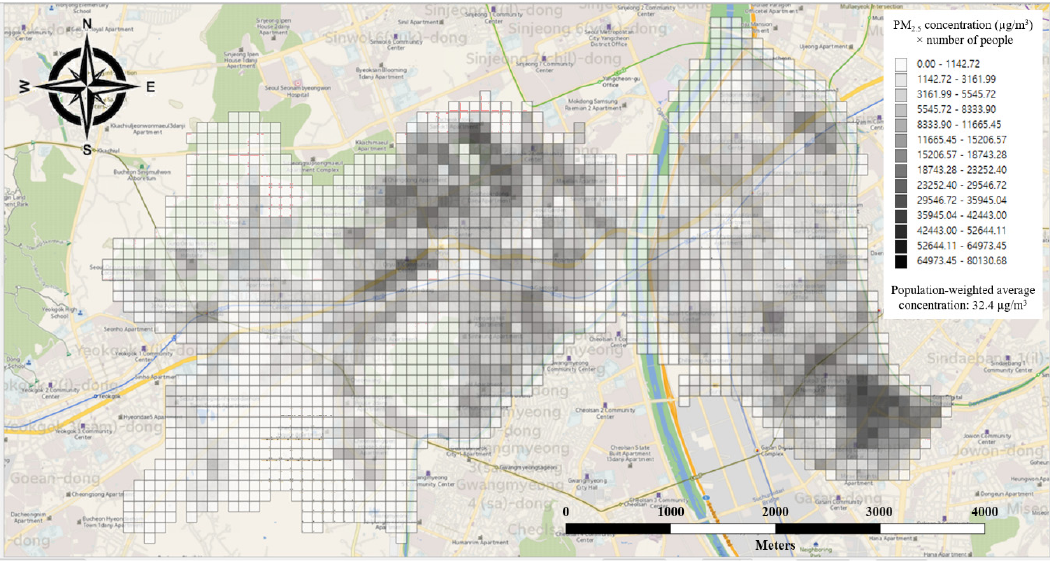
Figure 9. Population exposure to PM 2.5 in Guro-gu .